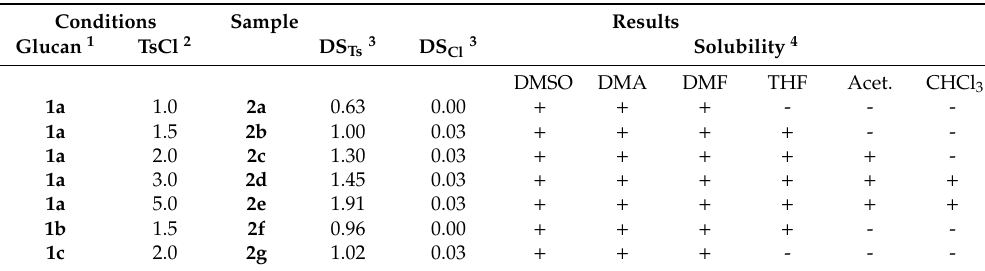
Table 1. Conditions for and results of the conversion of 1,3-glucans dissolved in N , N -dimethyl acetamide / LiCl with p -toluenesulfonic acid chloride (TsCl) in the presence of triethylamine for 24 h at 8 ◦